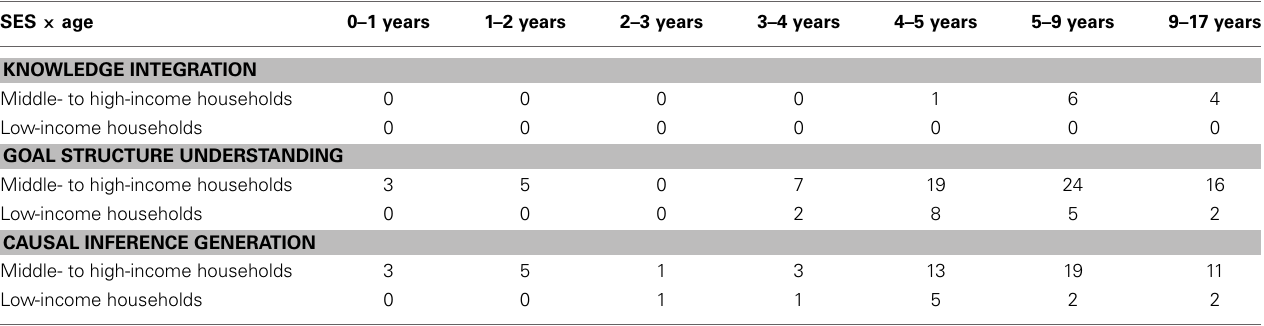
Table 1 | Numbers of sources describing narrative comprehension processes across populations from low- and middle- to high-income